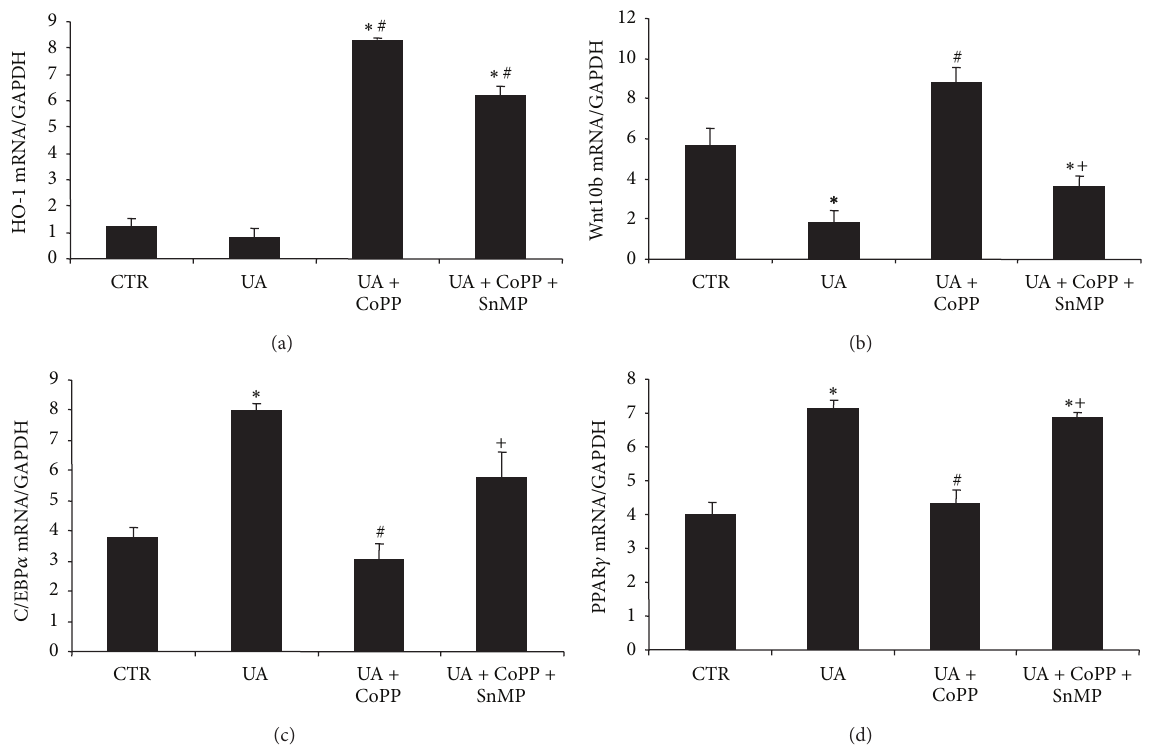
Figure 5: Real-time PCR of (a) HO-1; (b) Wnt10b; (c) C/EBP 𝛼 ; and (d) PPAR 𝛾 expression in MSCs treated with uric acid with or without CoPP, in the presence or absence of SnMP. Values represent means ± SEM of five independent treatments. ∗ 𝑝 < 0.05 versus CTR; # 𝑝 < 0.05 versus UA; and + 𝑝 < 0.05 versus UA + CoPP.